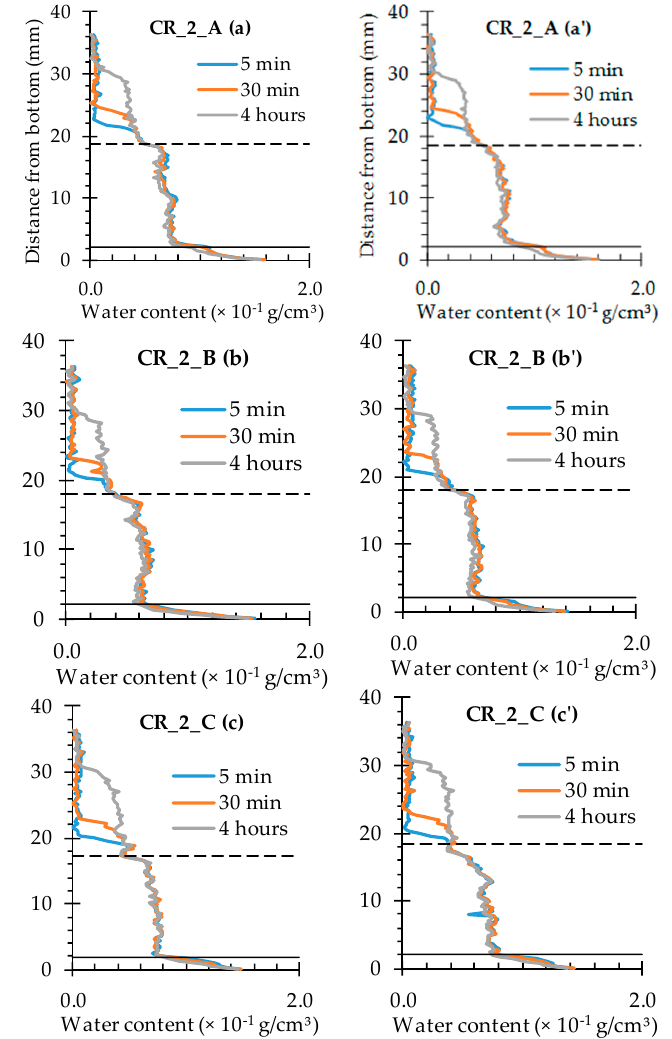
Figure 17. Water profiles along the crack as a function of exposure time for the neutron radiography images of the three standard mortar prisms containing two artificial cracks: ( a ) CR_2_A crack on the left; ( a’ ) CR_2_A crack on the right; ( b ) CR_2_B crack on the left; ( b’ ) CR_2_B crack on the right; ( c ) CR_2_C crack on the left; and ( c’ ) CR_2_C crack on the right.